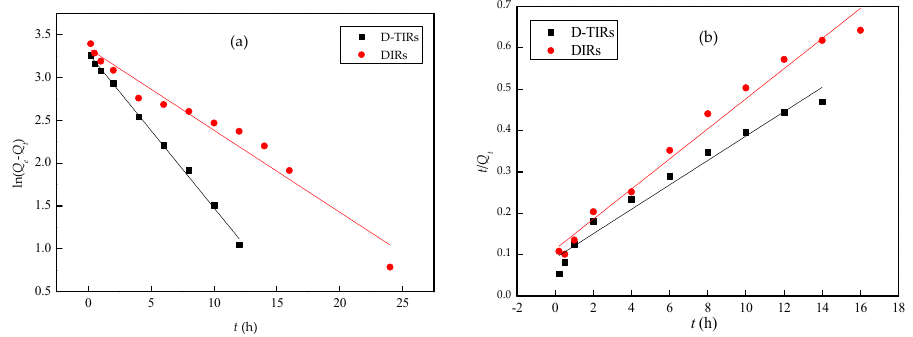
Figure 6. Fitting of the adsorption kinetics of V(IV) onto resins by ( a ) pseudo-first order model and ( b ) pseudo-second order model. Table 3. Fitting parameters of the adsorption of V(IV) onto the SIRs.